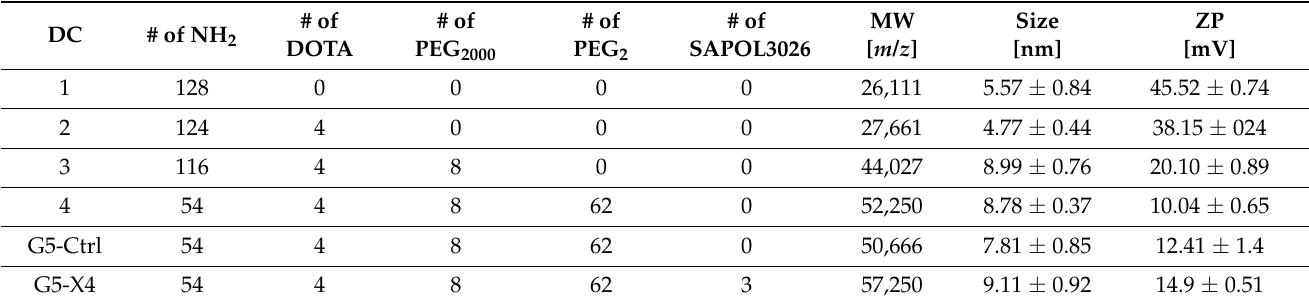
Table 1. Physicochemical characterization of dendrimer